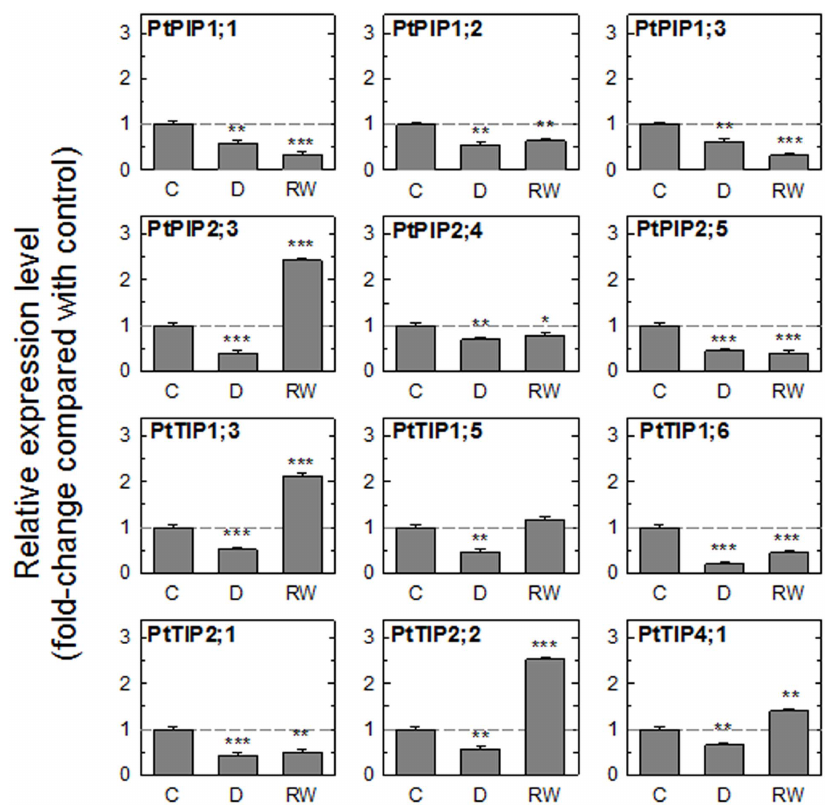
Figure 5. Relative expression of aquaporin genes in detached leaves during a dehydration-rehydration experiment. Data are from control leaves (C) after they were perfused with artificial xylem sap (AXS) for 2 h, leaves that were dehydrated on the bench top for 1 h (D), and leaves that were dehydrated on the bench top for 1 h and then perfused for 2 h with AXS (RW). The geometric mean of the expression levels of four reference genes ( ACT2 , CYC063 , TIP41-like , UBQ7 ) was used to normalize the results. Asterisks denote significant differences in expression level compared to control levels (one-way ANOVA, followed by Bonferroni’s post test, * P # 0.05; ** P # 0.01*** P # 0.001). Data are means 6 SE of three biological replicates.